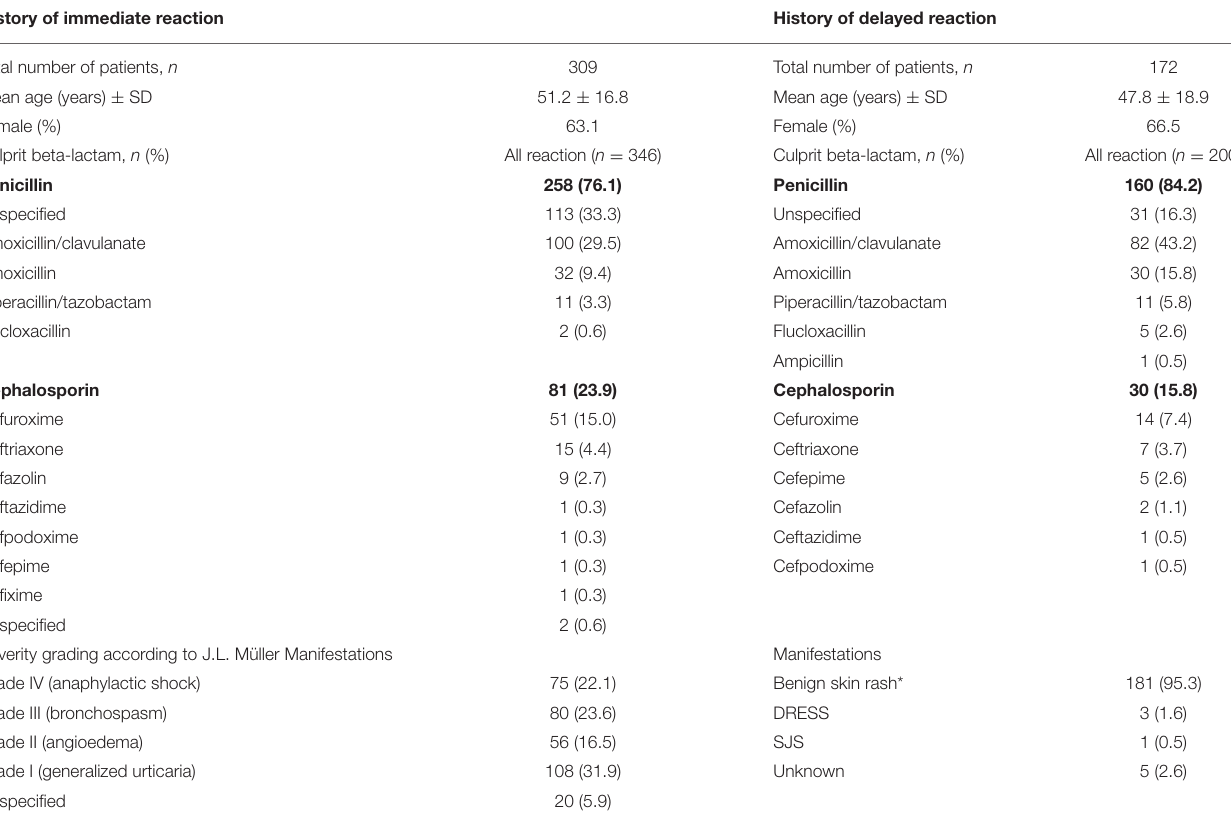
TABLE 1 | Characteristics of 436 patients with a history of immediate- and delayed-type reactions to beta-lactam